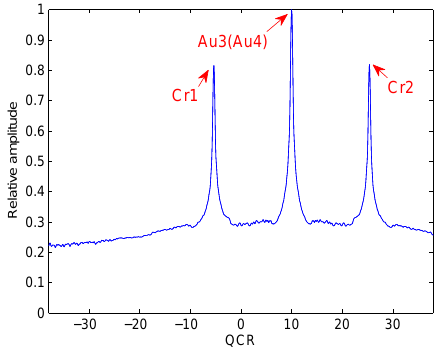
Figure 2. Cross-term suppression of